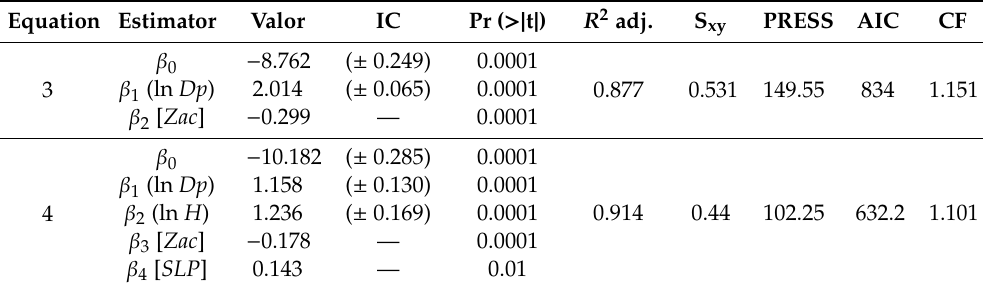
Figure 2. Atypical observations detected for the Agave lechuguilla Torr. aboveground biomass models in Mexico ( a , b ) and with no atypical observations for both equations ( c , d ). Table 3. Statistics of the models (without outliers) for estimating aboveground biomass of Agave lechuguilla Torr. in